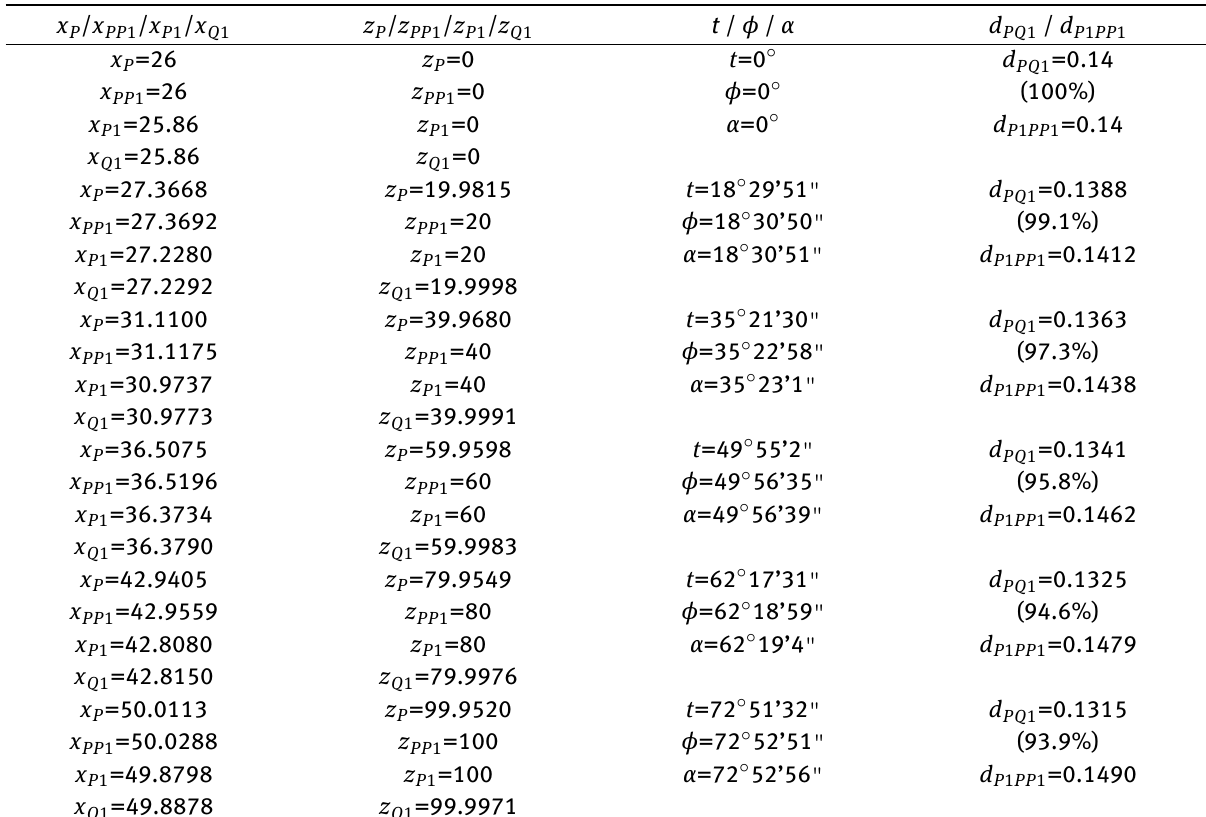
Table 2: Coordinates of points P , P P 1 , P 1 and Q 1 , the angle t (for the point P ), ϕ (for the point Q 1 ), α (for the point P P 1 ) and distances d PQ 1 and d P 1 PP 1 measured at successive heights of the Rybnik